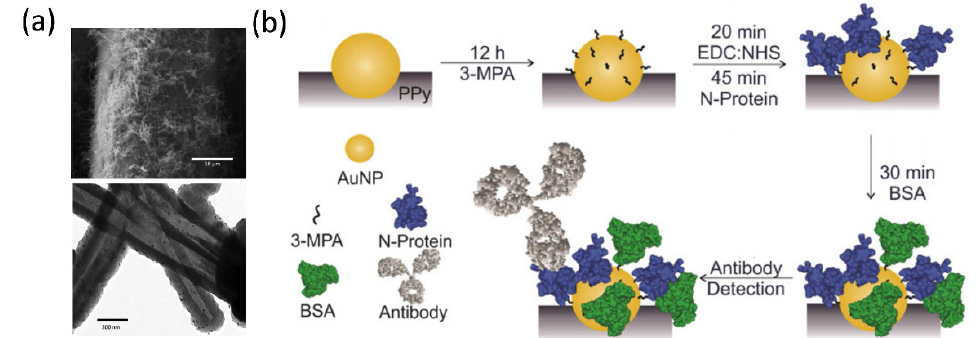
Figure 5. Responsive plasmonic nanostructures for biosensing. ( a ) SEM (top panel) and TEM (bottom panel) of the polypyrrole nanotubes decorated with Au nanoparticles. ( b ) Schematic illustration of the preparation and working principle of the biosensors for antibody detection. Reprinted from [141], with permission from Elsevier Ltd.